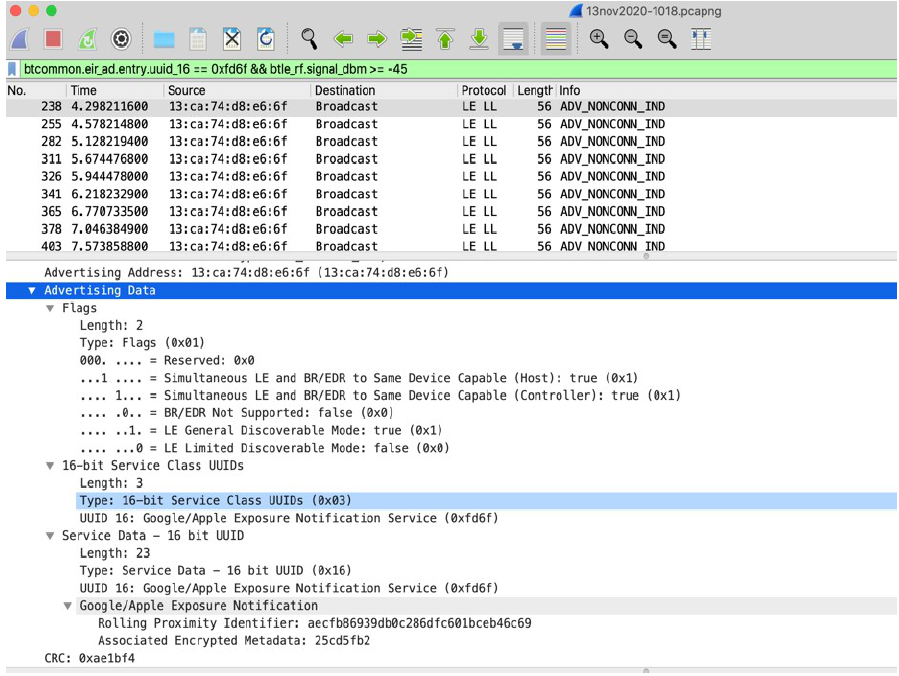
Figure 8. Victim uses GAEN; displays